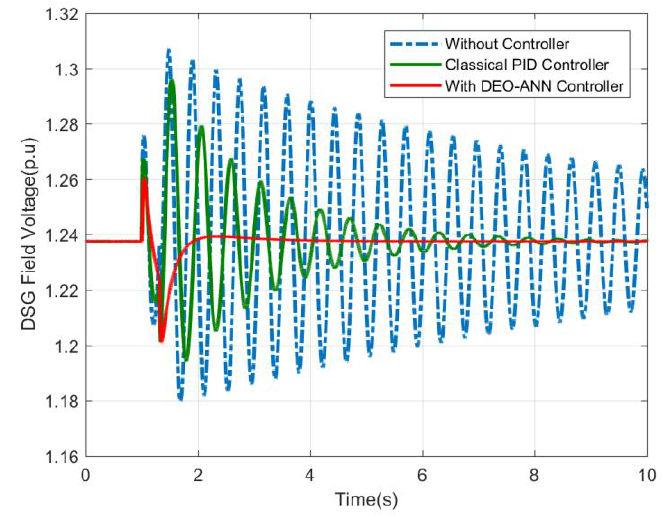
Figure 15. DSG field voltage.